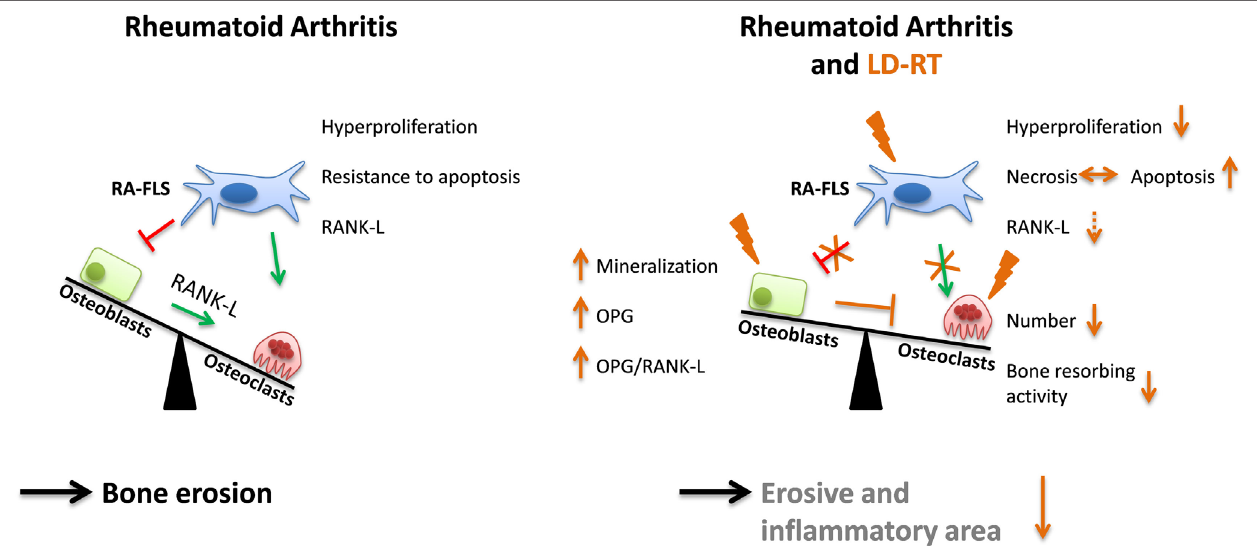
FigUre 7 | Low-dose irradiation positively impacts on bone metabolism. In rheumatoid arthritis (RA) a misbalanced relationship of bone resorption by osteoclasts and bone formation by osteoblasts leads to destruction of joints. In the affected joint, fibroblasts like synoviocytes (RA-FLS) show a rather aggressive phenotype that is characterized by hyperproliferation, resistance to apoptosis, and receptor activator of nuclear factor κ B-ligand (RANK-L) expression. Following low-dose radiotherapy (LD-RT) with in particular 0.5 Gy, the inflammatory (reduced neutrophil extracellular trap) and erosive area is reduced, since LD-RT particularly positively impacts on RA-FLS, osteoblasts, and osteoclasts as schematically displayed in the illustration. Abbreviation: OPG, osteoprotegerin.